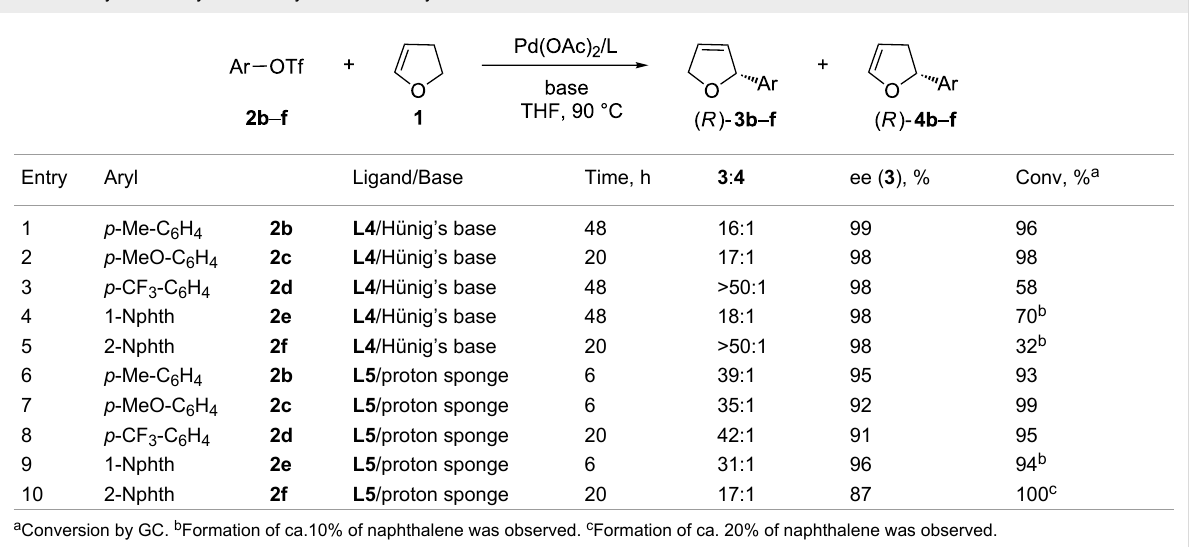
Table 4: Asymmetric arylation of dihydrofuran with aryl tiflates.